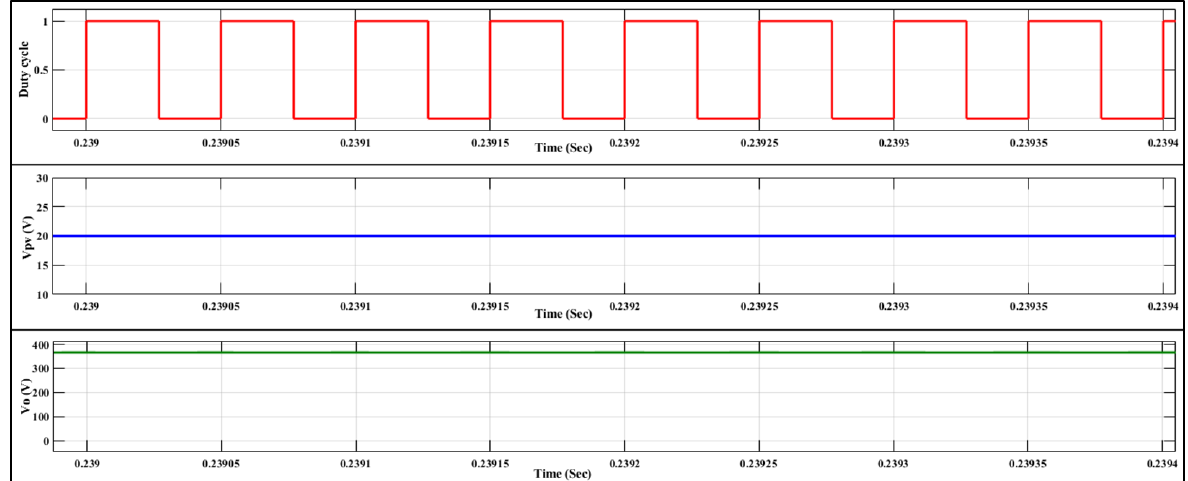
Figure 9. Simulated waveform for solar PV module output voltage (V pv ) and output voltage (V o ) of the proposed HVGSU converter at the 0.54 duty cycle.